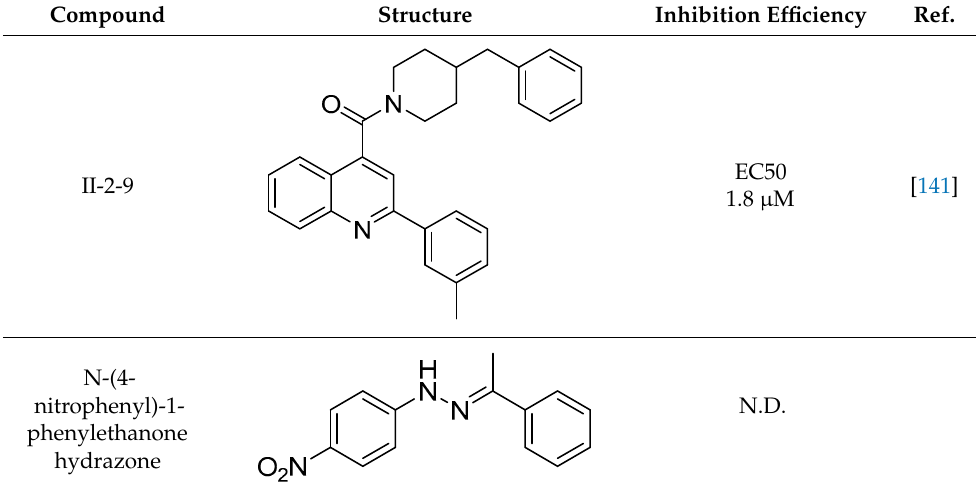
Table 2. Cont. Compound Structure Inhibition Efficiency